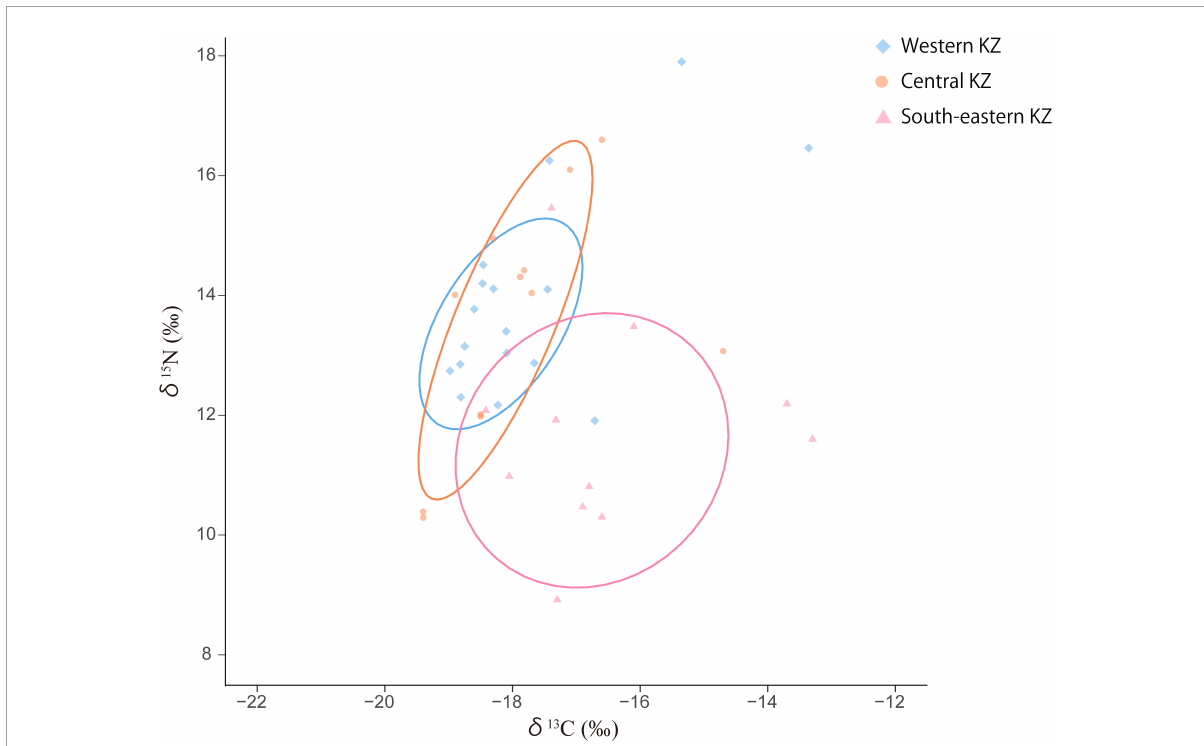
FIGURE7 Scatter plots with 68.3% (1 σ ) confidence ellipses of the stable carbon and nitrogen isotope values of human bone collagen from the Late Bronze Age to the Iron Age Kazakhstan (after Ananyevskaya et al., 2020; Figure 5